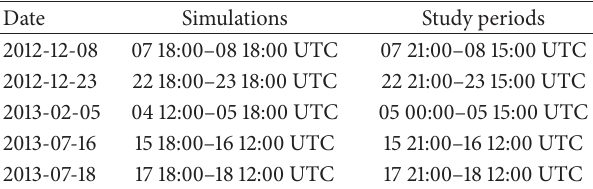
Table 3: Simulation periods for the selected case